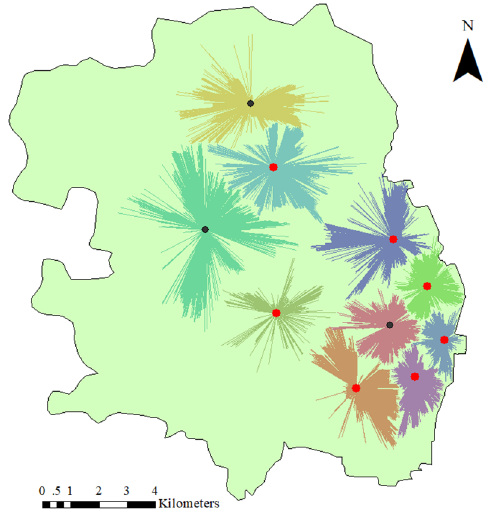
Figure 5. Maximum coverage of fire stations after planning. (The lines with different colors in represent the POIs assigned to different fire stations; The red and black dots represent the existing and newly added stations respectively.)